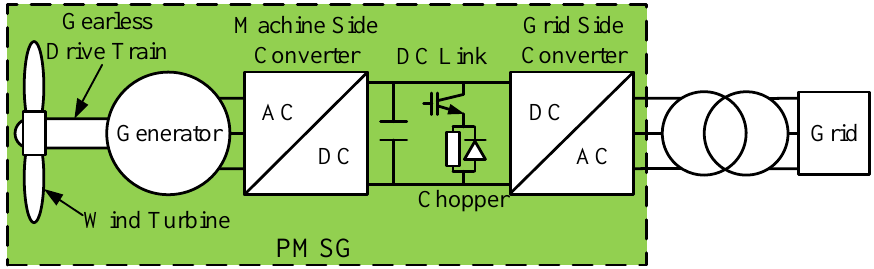
Figure 1. Configuration of a wind turbine with direct-driven permanent magnet synchronous generator (PMSG).